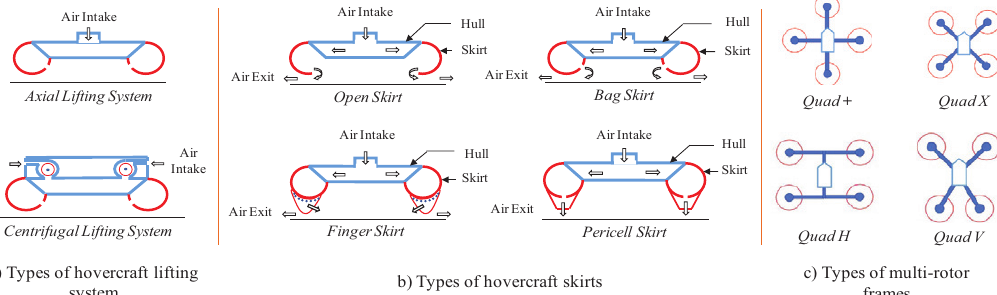
Figure 5. Design alternatives of UAAV components: a) lifting system, b) skirt, c) multi-rotor